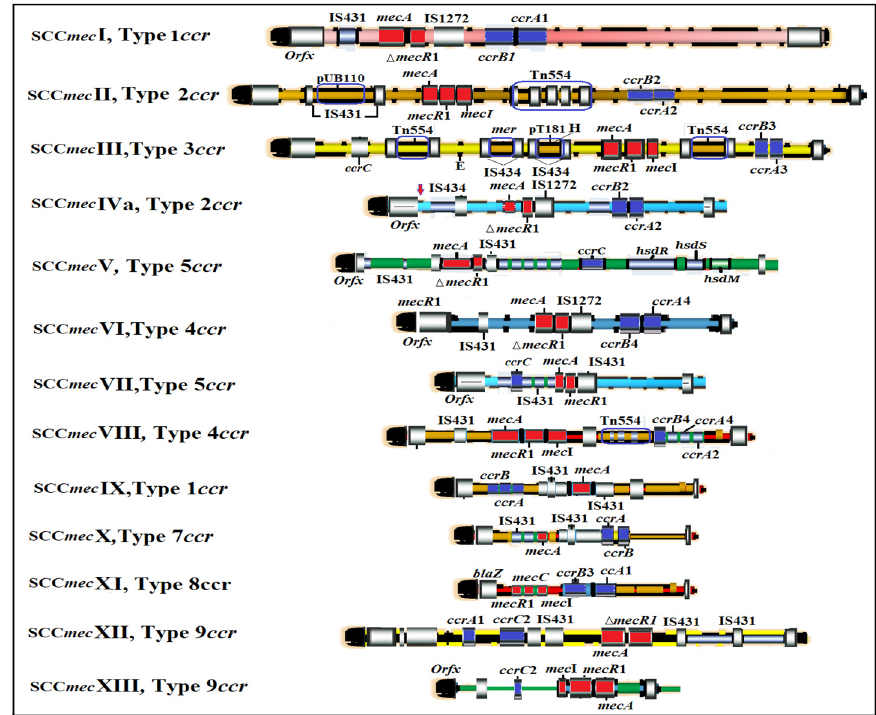
Figure 2. Scale representation and comparison of the 13 SCC mec types. Mec gene complex (red), ccr gene complex (indigo), ORFs within the SCC mec elements (blue), and chromosomal ORFs (black). (Adapted with permissions from Ref. [33]. 2009, American Society for Microbiology)